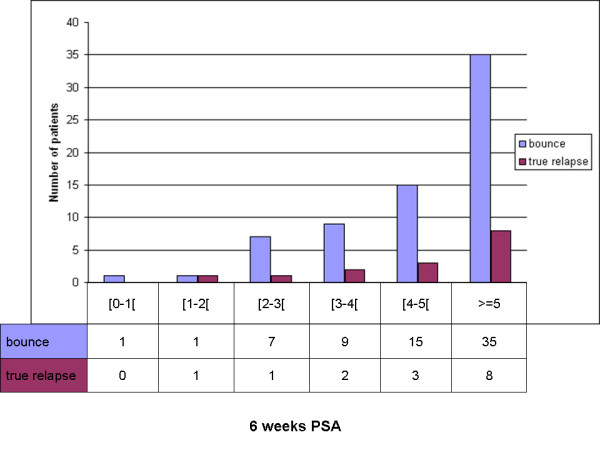
6 week PSA value according to patients outcome: BF or bounce.